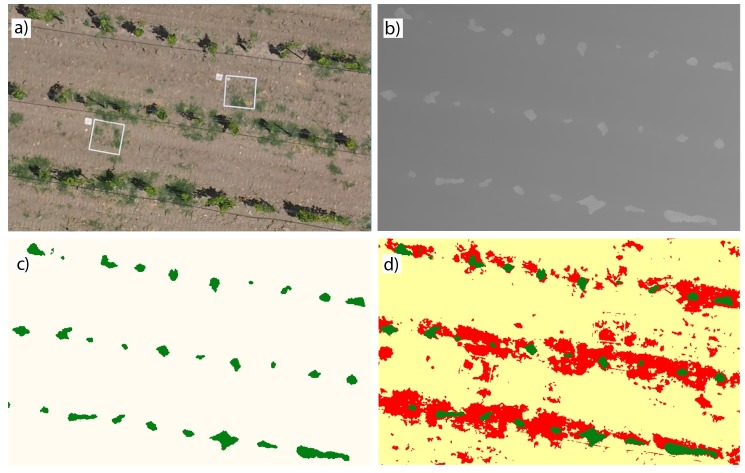
Several stages of the OBIA algorithm for an enlarged view belonging to field A-2016 and RGB camera.a) the RGB bands, b) the DSM of the orthomosaic, c) vine line classification (grapevines in green color and no-vineyard objects in white color), and d) classified map (grapevines in green color, bermudagrass patches in red color, and bare soil in yellow color).